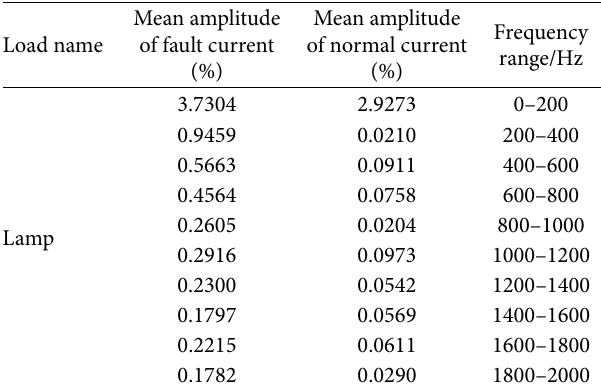
Table 3: Frequency domain feature values of lamp load circuit.